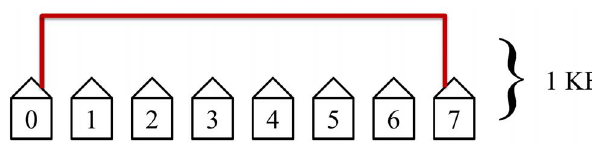
Figure 13. Only one key exchange is performed in this step. Host 1 through 6 are not allowed access to KLJN band thus they are in State 1. The seventh and the last step. This step is not efficient but only requires one KE since there is only one such pair of hosts.